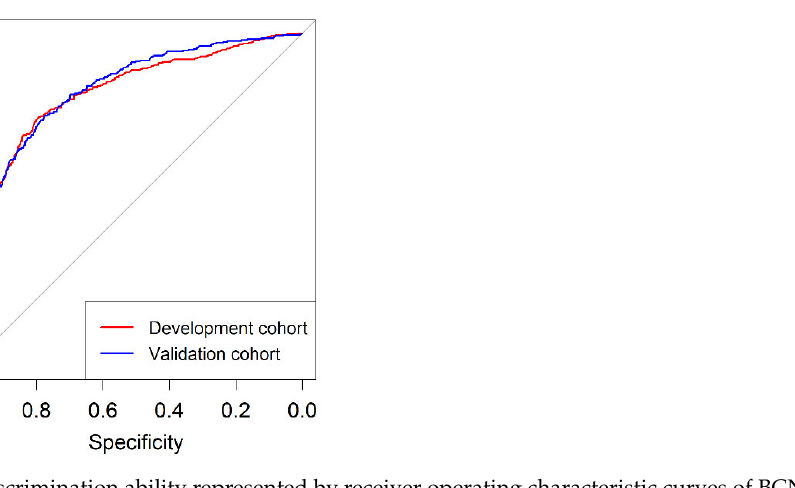
Figure 3. Discrimination ability represented by receiver operating characteristic curves of BCN-RC 1 in the development cohort and validation cohort.